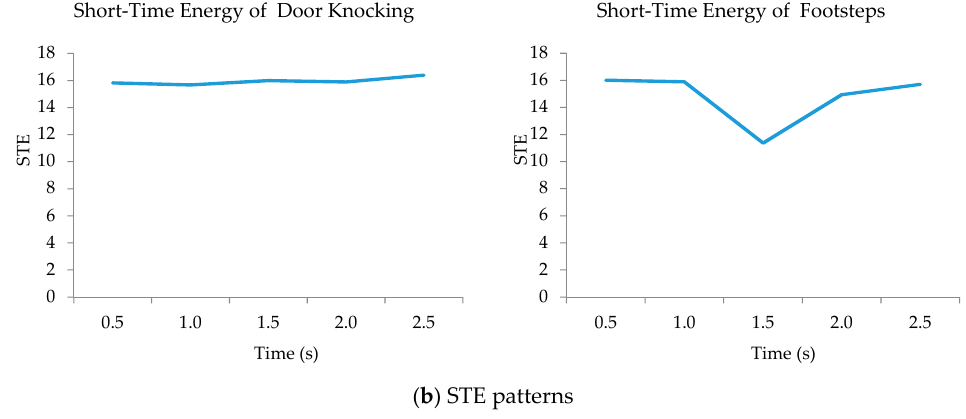
Figure 7. MFCCs ( a ) and STE ( b ) patterns of door knocking and footstep .